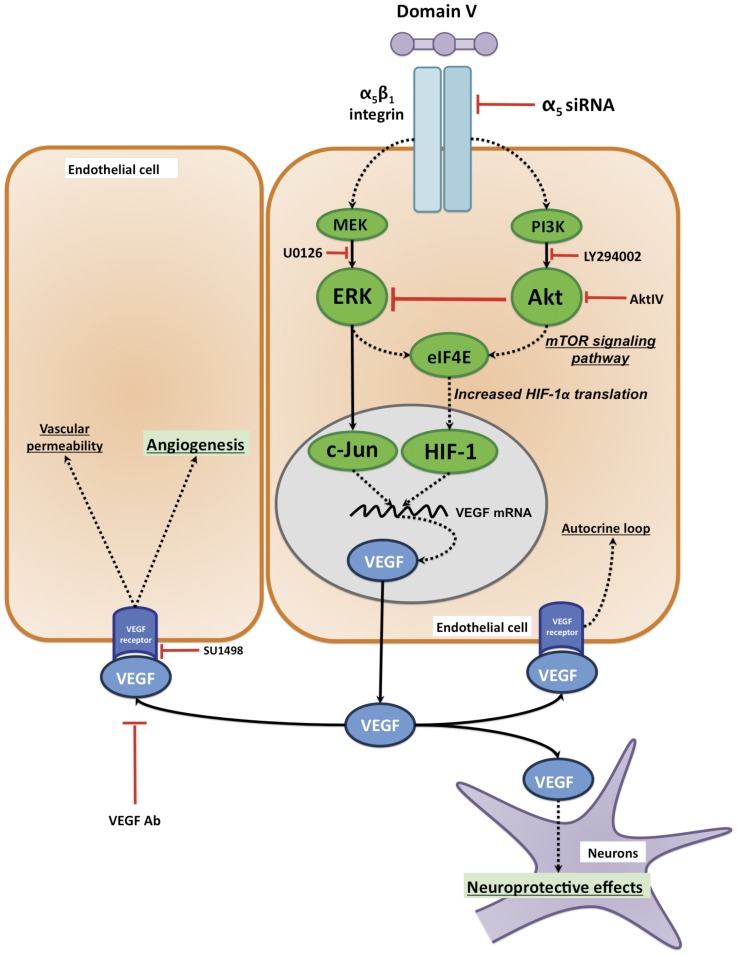
Schematic representation of DV signal transduction, VEGF gene expression, secretion and its subsequent activity at the neurovascular unit.Proposed model by which DV interaction with the BEC α5β1 integrin results in increased VEGF production and secretion. The use of various antagonists (red lines) is also shown.